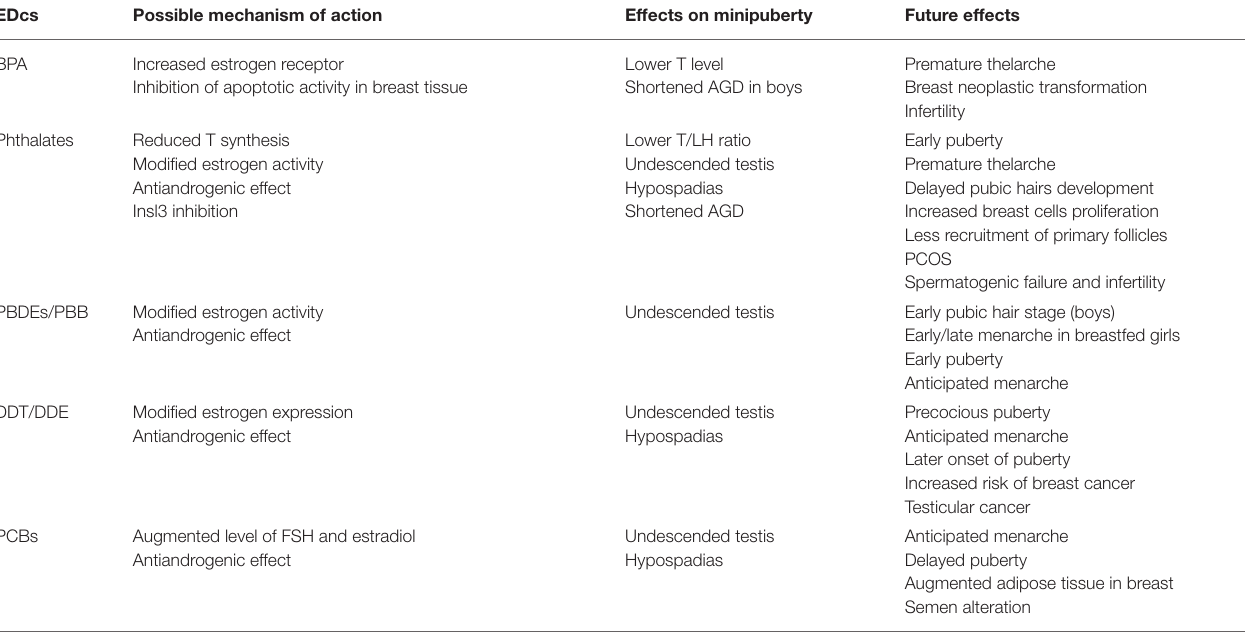
TABLE 1 | Possible effects in humans of the main EDCs on minipuberty and long-term consequences